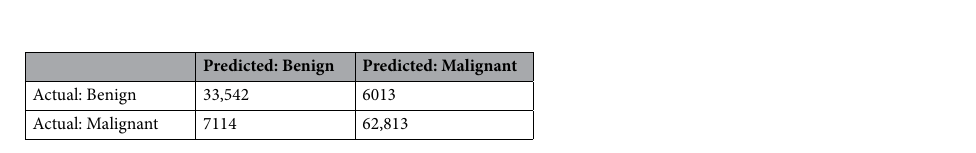
Table 6. Confusion matrix of supervised learning: image-based evaluation (AlexNet-like model).